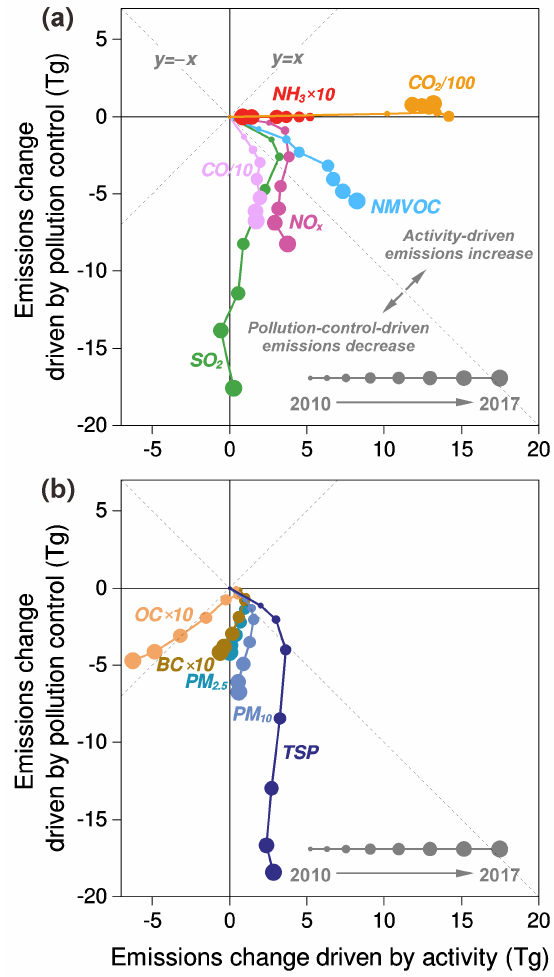
Figure 5. China’s emission pathways from 2010 to 2017. Gaseous pollutants are plotted in (a) , and particles are plotted in (b) . For each pollutant, the years (circle) are plotted according to the emission changes caused by activity ( A in Eq. 2, x axis) and pollution control (the sum of x , E , and η in Eq. 2, y axis). Please refer to Fig. S1 in the Supplement for decomposition analysis results of A , x , E , and η . The intersecting lines y = x and y = − x divide the coordinate plane into four sections. Any point in the section on the right side of the two lines reflects increasing emissions due to activity growth, and the points in the section below the two lines reflect decreasing emissions driven by pollution control.